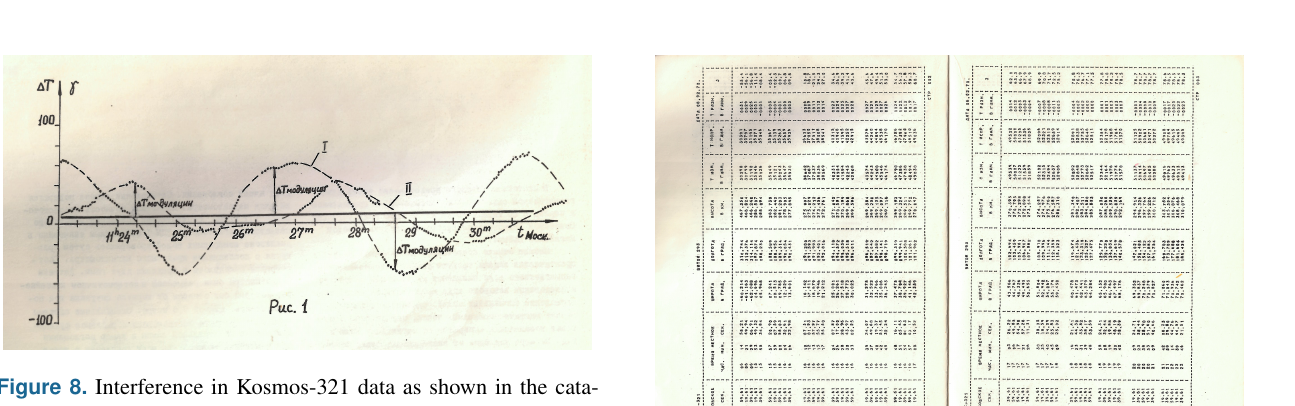
Figure 7. Magnetic field map measured by Kosmos-49.